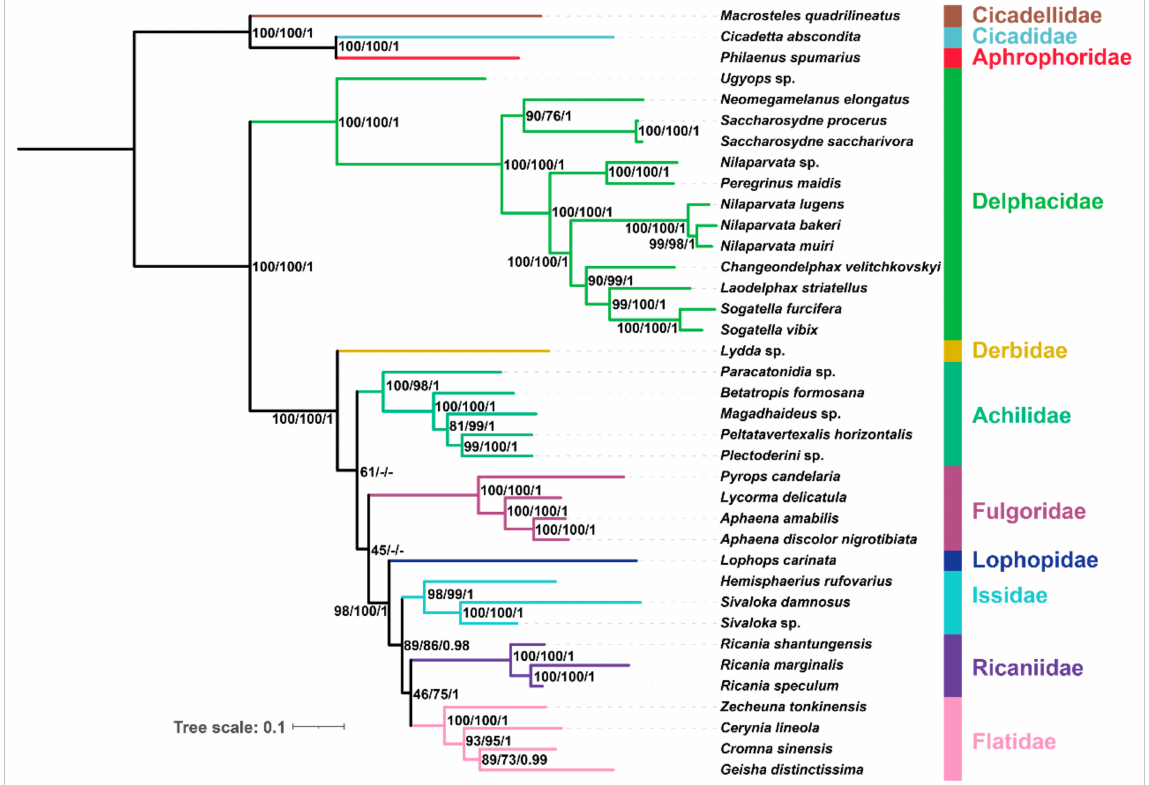
Figure 6. Phylogenetic tree inferred from IQ-TREE and MrBayes based on the datasets of AA and PCG12. Supports at nodes (from left to right) are ML bootstrap support values (BS) for AA, PCG12, and then Bayesian posterior probabilities (PP) for PCG12. “-” indicates the clades are